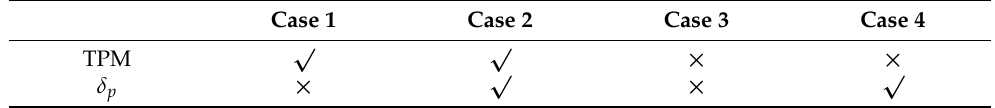
Table 2. Consideration judgment of TPM and δ p for four